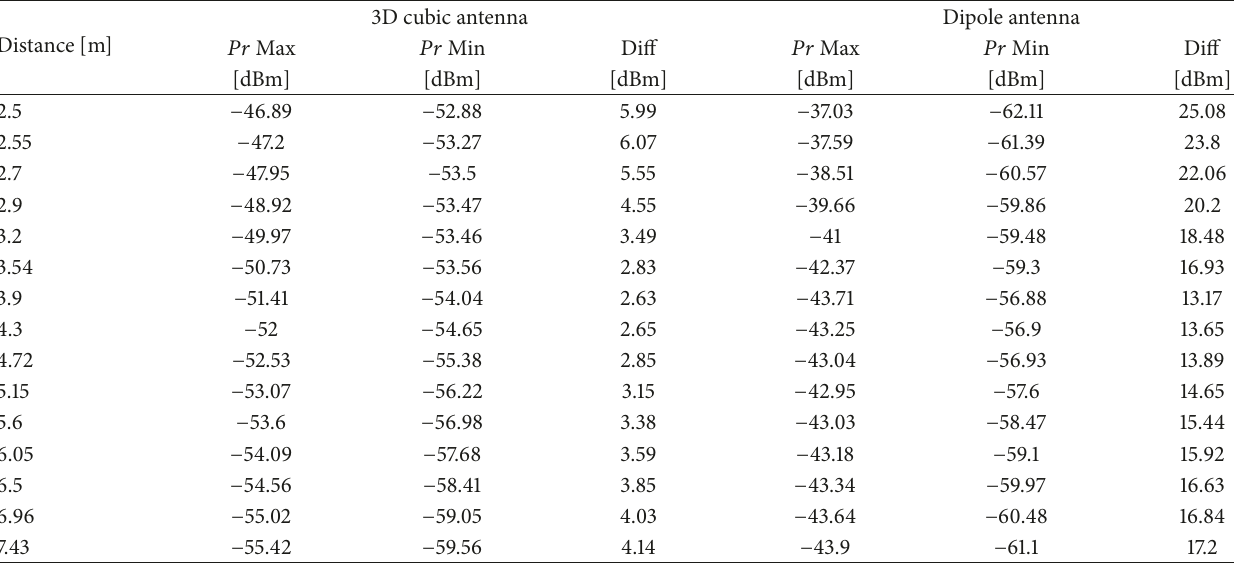
Table 5: Difference between 𝑃𝑟 Max and Min in the NLOS